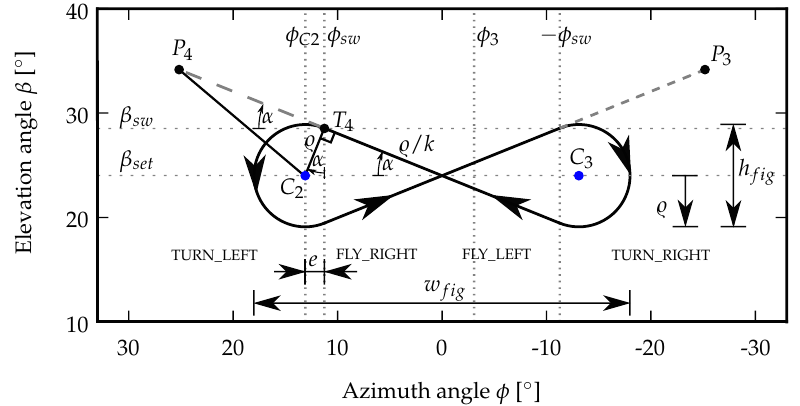
Figure 7. Figure-of-eight geometry for the derivation of Equations